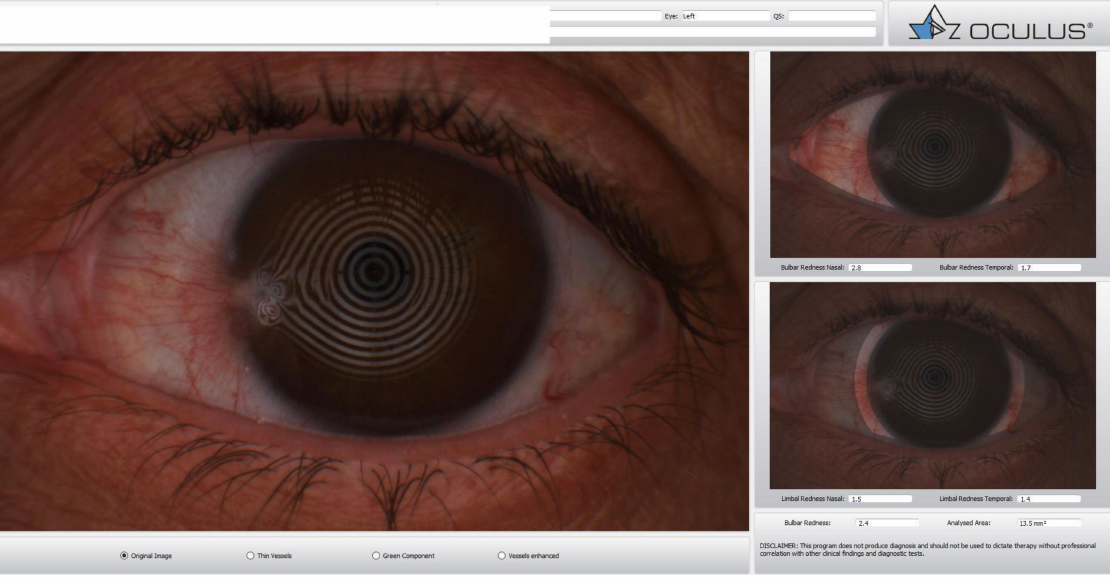
Figure 5. Redness artefact due to the presence of a wing-shaped pterygium. Image obtained with Keratograph5 M (Oculus Optikgeräte GmbH, Wetzlar,